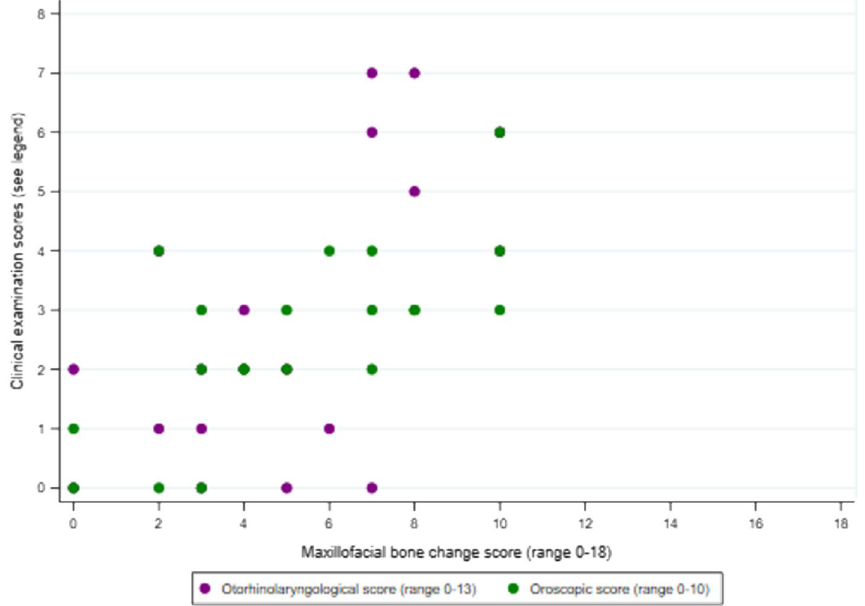
Figure 2. Correlation between otorhinolaryngological and oroscopic findings and maxillofacial bone alterations in current Hansen’s disease patients (see Table 4 for correlation